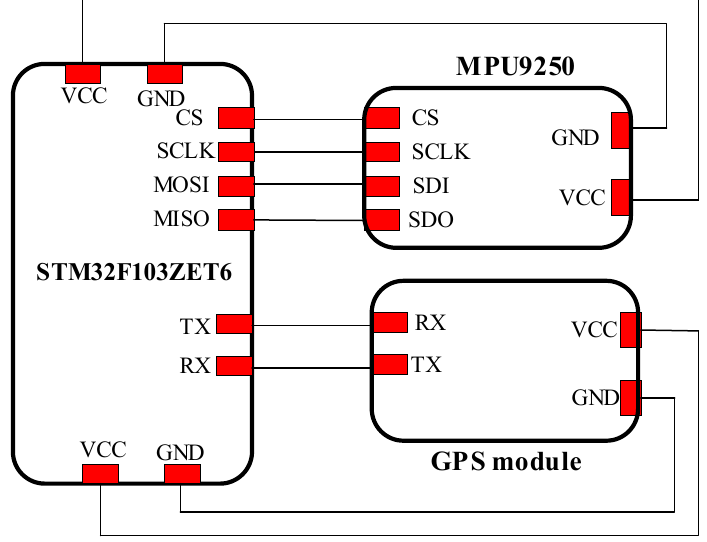
Figure 4. The architecture of the automatic positioning cruise system. GPS, global positioning system; VCC, volt current condenser; GND, ground; TX, transport; RX, receive; CS, chip select; SCLK, serial clock; MOSI, master out slave in; MISO, master in slave out; SDI, serial data input; SDO, serial data output.